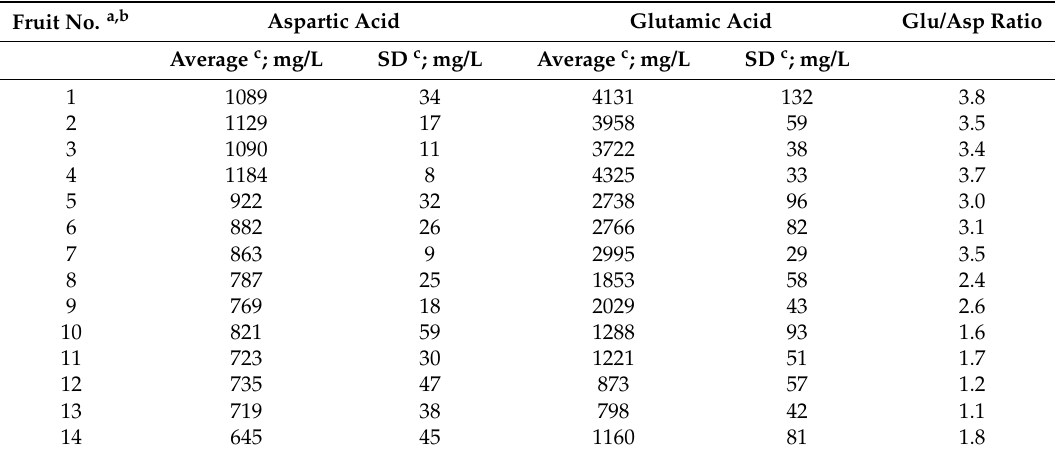
Table A2. Aspartate and glutamate contents during ripening of tomato